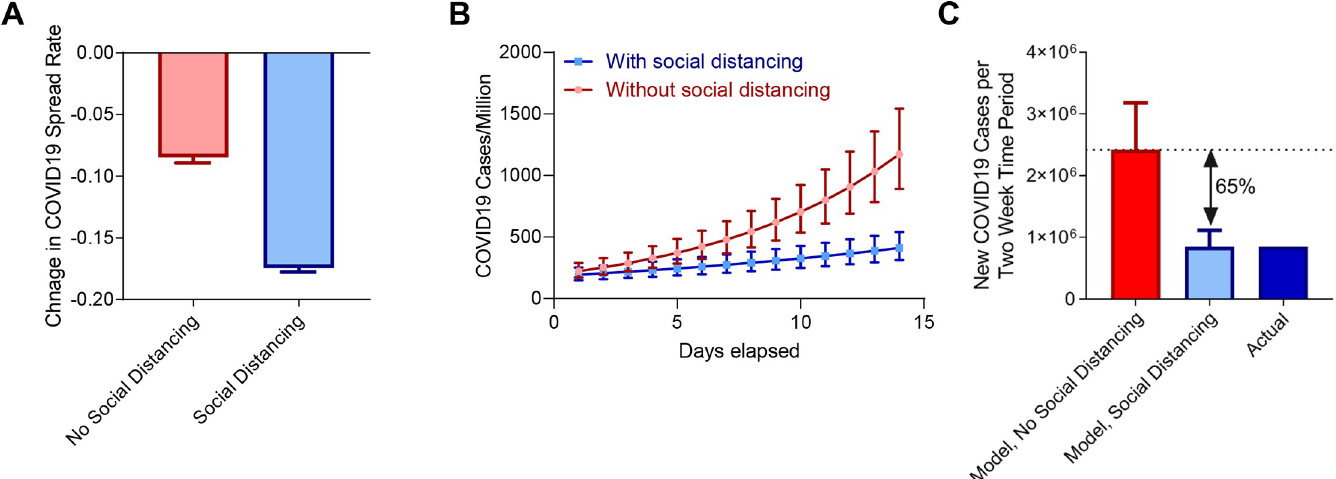
Fig 4. Prevention of new COVID19 cases by social distancing policies. (A) Change in COVID19 spread rates following implementation of social distancing policies (blue), or time-equated periods in countries with no social distancing policies (red). Data were fit using a generalized linear mixed-effects model taking each country as a random effect. Bars represent change in regression coefficient ± standard error. (B) Modeling of new COVID19 cases per million inhabitants in countries with social distancing policies using either model fit directly to data following implementation of social distancing policies (blue), or after correcting for the observed reduction in COVID19 spread rates associated with social distancing policies (red). Points represent model COVID19 cases per million ± standard error. (C) Estimation of total new cases over a two-week period if countries had not implemented social distancing policies (red), with implementation of social distancing policies (light blue), and actual new cases (dark blue). Bars represent number of COVID19 cases in the countries with social distancing policies ± standard error.